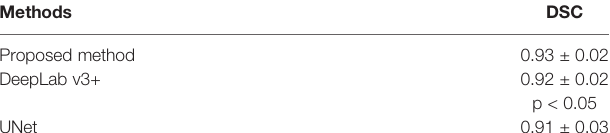
TABLE 5 | Quantitative DSC comparisons with baseline methods.